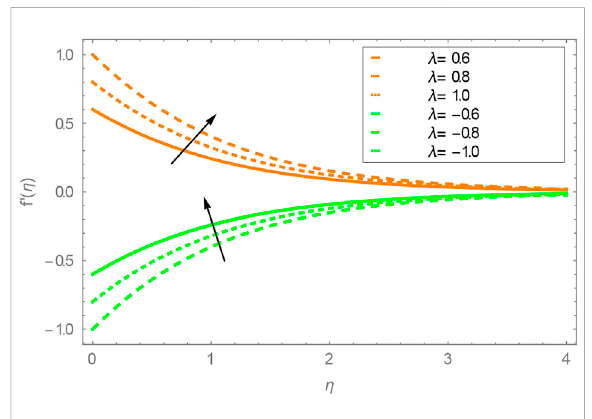
FIGURE 10 Inspiration of shrinking and stretching parameters λ on the velocity pro fi le.